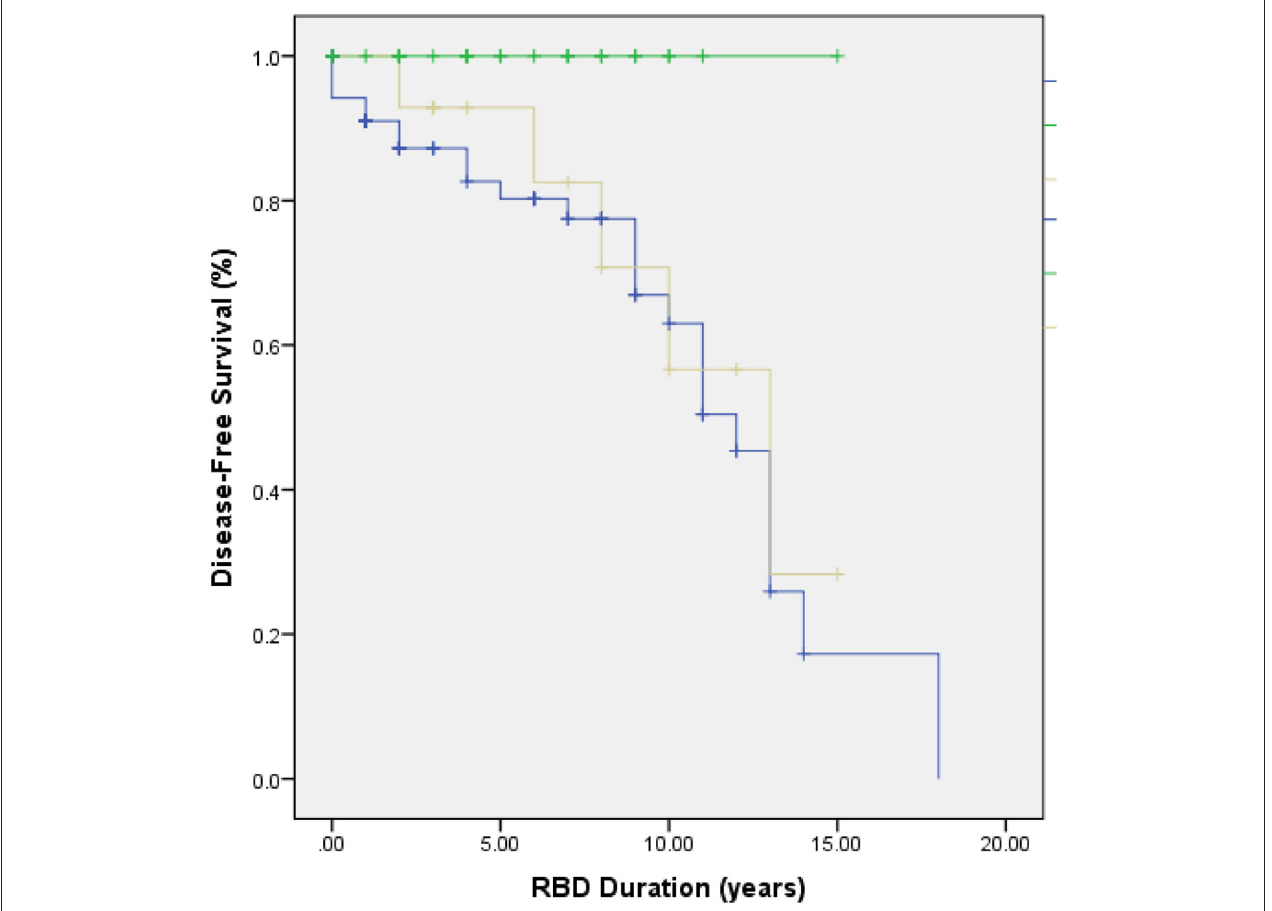
FIGURE 2 | Kaplan-Meier plot of neurodegenerative disease-free survival in Group 1 (blue line), Group 2 (yellow line), and Group 3 (green line). Disease-free survival in RBD patients differed significantly across groups ( p = 0.01).